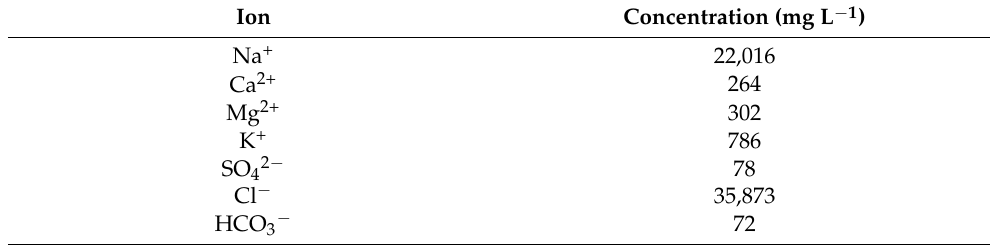
Table 2. Composition of the brine (synthetic desulphated saline water) used in the formulation of aqueous